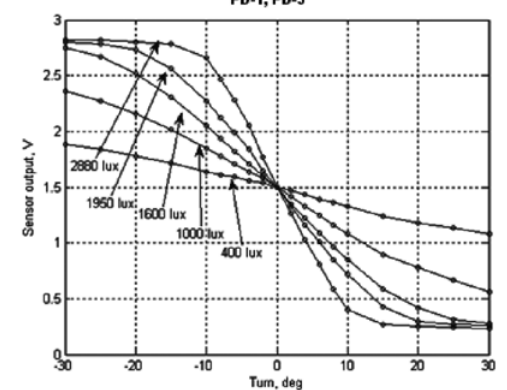
Fig. 8. Vertical directional diagrams of PD-1, PD-3